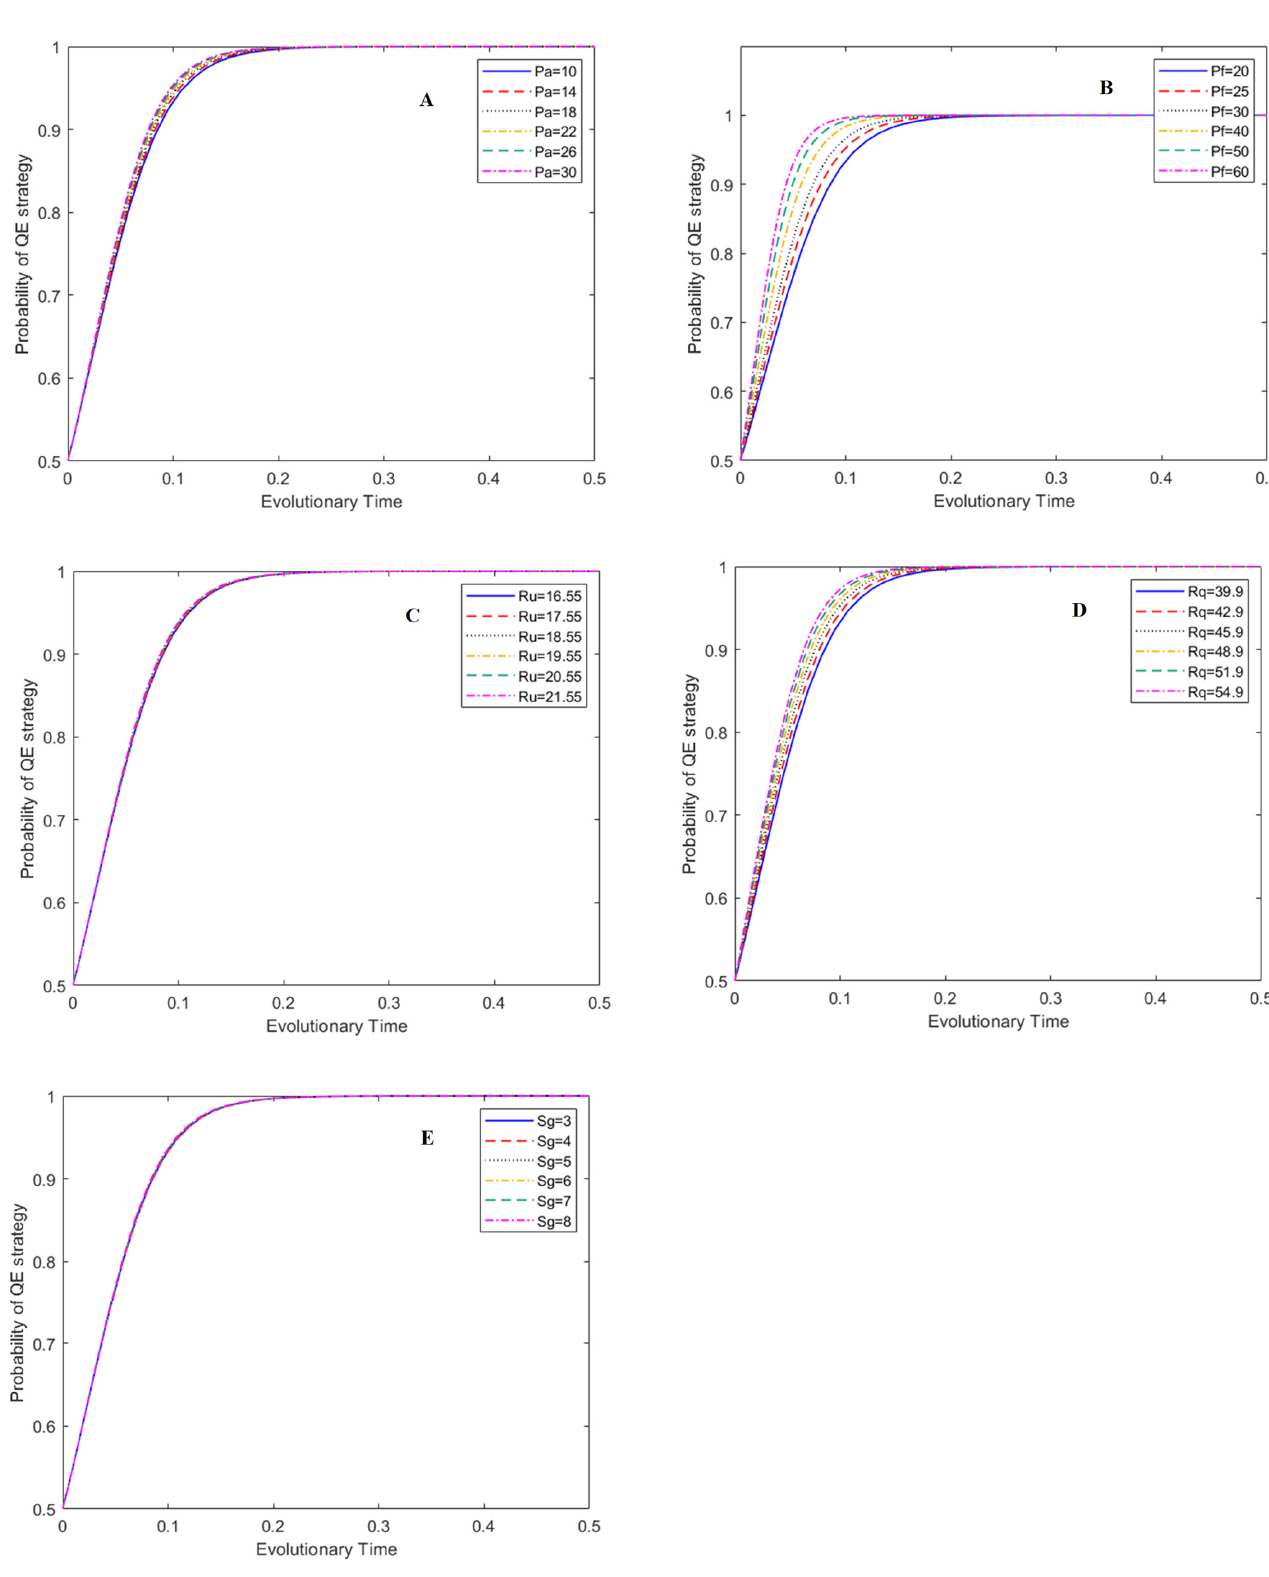
Figure 5. Effects of main parameters on the evolution of QE strategy under (1,1,0), , subfigures A–E represent the effects of P a , P f , R u , R q , and S g on the evolution of QE strategies, respectively.